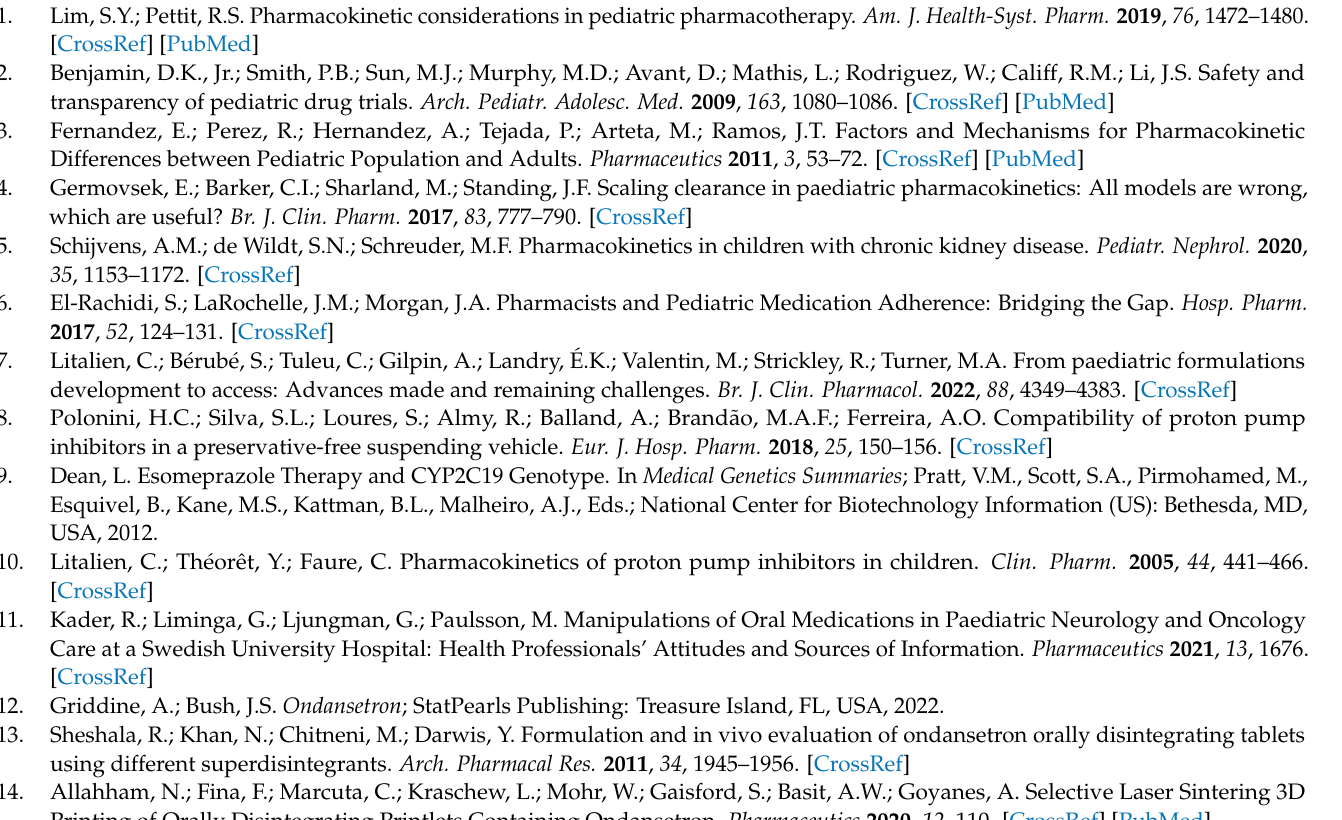
Figure S5. Diffractogram of PVA Mw30 analysis by X-RPD technique; Figure S6: PVA Mw30 TG/DSC (STA) thermogram; Figure S7: Diffractograms of esomeprazole Mg 2H 2 O and 3H 2 O analysis by X-RPD technique; Figure S8: Ondansetron TG/DSC (STA) thermogram; Figure S9: DSC mixtures thermograms of PVP K17 with esomeprazole: esomeprazole Mg 2H 2 O (a) and esomeprazole Mg 3H 2 O (b); Figure S10 : DSC mixtures thermograms of PVP K25 with esomeprazole: esomeprazole Mg 2H 2 O (a) and esomeprazole Mg 3H 2 O (b); Figure S11: DSC mixtures thermograms of PVP K90 with esomeprazole: esomeprazole Mg 2H 2 O (a) and esomeprazole Mg 3H 2 O (b); Figure S12: DSC mixtures thermograms of PVA Mw30 with different APIs: esomeprazole Mg 2H 2 O (a); esomeprazole Mg 3H 2 O (b) and ondansetron